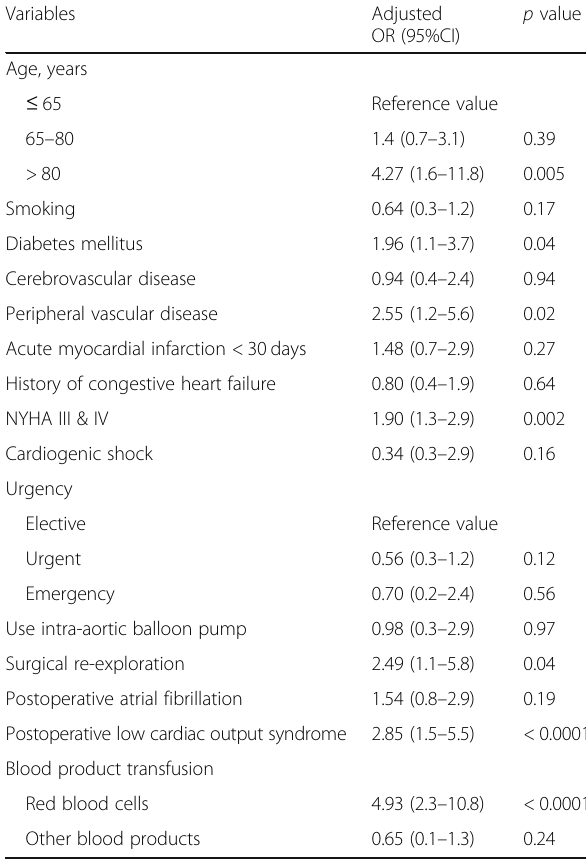
Table 3 Multivariable analysis of predictors of postoperative acute kidney insufficiency (AKI) in isolated coronary